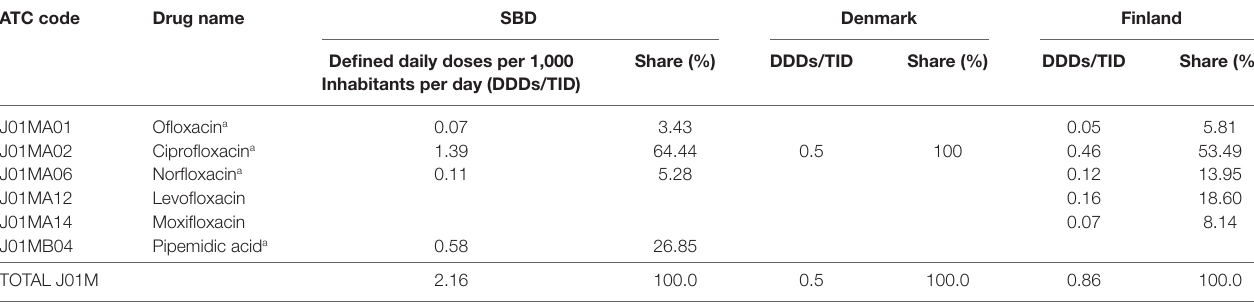
TaBle 6 | Utilization of antibiotics within quinolones subgroup (J01M) in South Backa District (SBD), Denmark, and Finland in 2008. aTc code